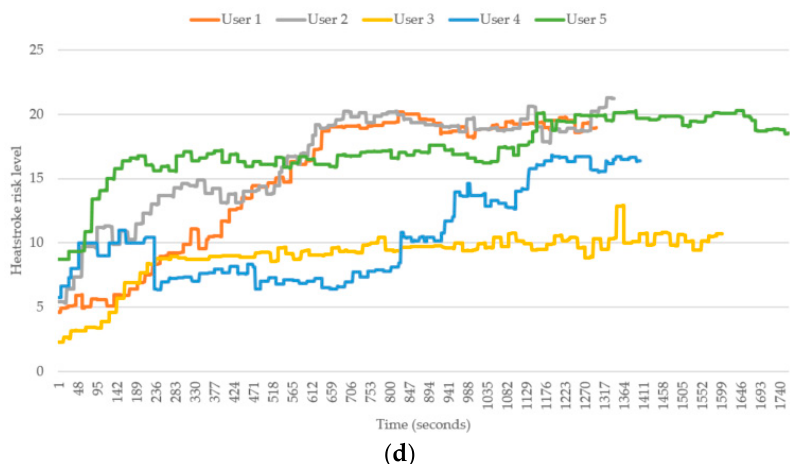
Figure 13. Comparison between the physiological data and the feedback signals of the five users during running outdoors. ( a ) Galvanic skin response (GSR); ( b ) body temperature; ( c ) heartbeat; and ( d ) heatstroke risk level.